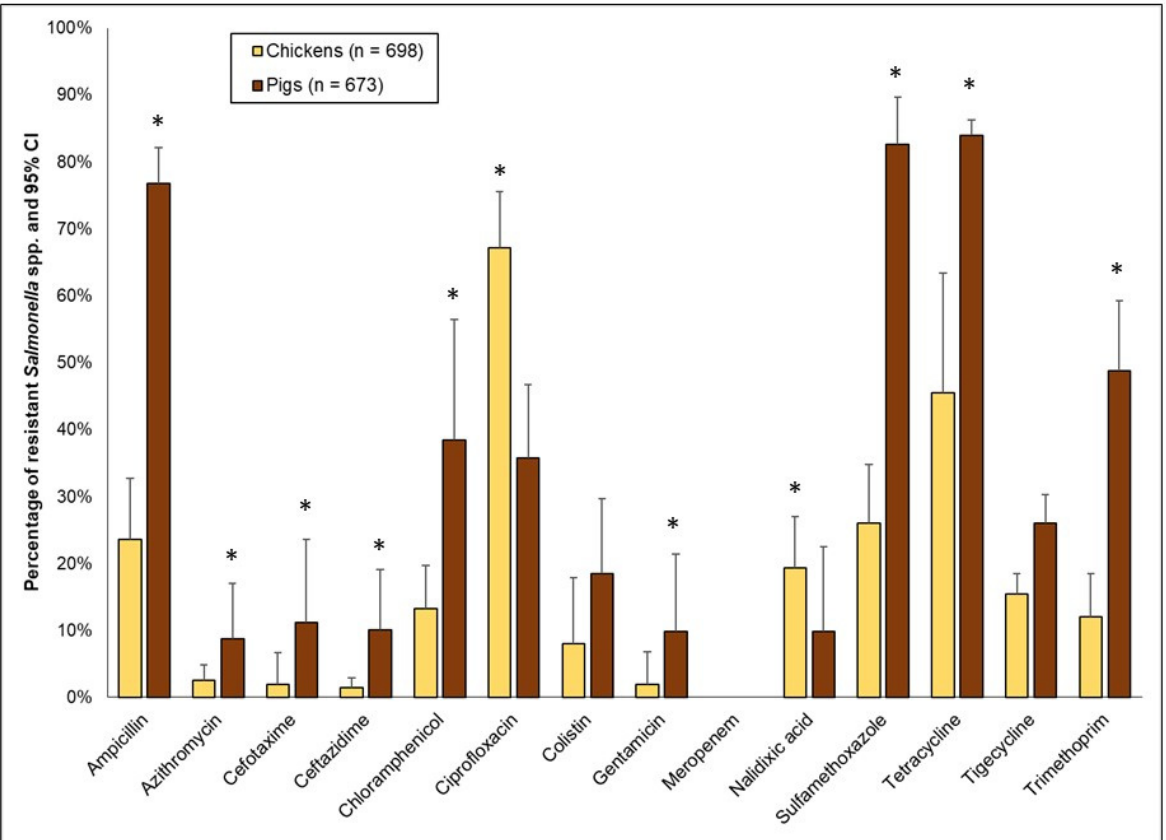
Figure 6. Percentages of antimicrobial resistance in Salmonella spp. from chickens ( n = 698 isolates; depicted by the yellow bars) and pigs ( n = 673; depicted by the brown bars), collected from five provinces in the Lao PDR, 2018–2021. High 95% confidence limits are shown. For each antimicrobial and species combination, the percentage of resistance was adjusted for clustering at the province level. Asterisks represent significant differences ( p ≤ 0.05), between chickens and pigs.